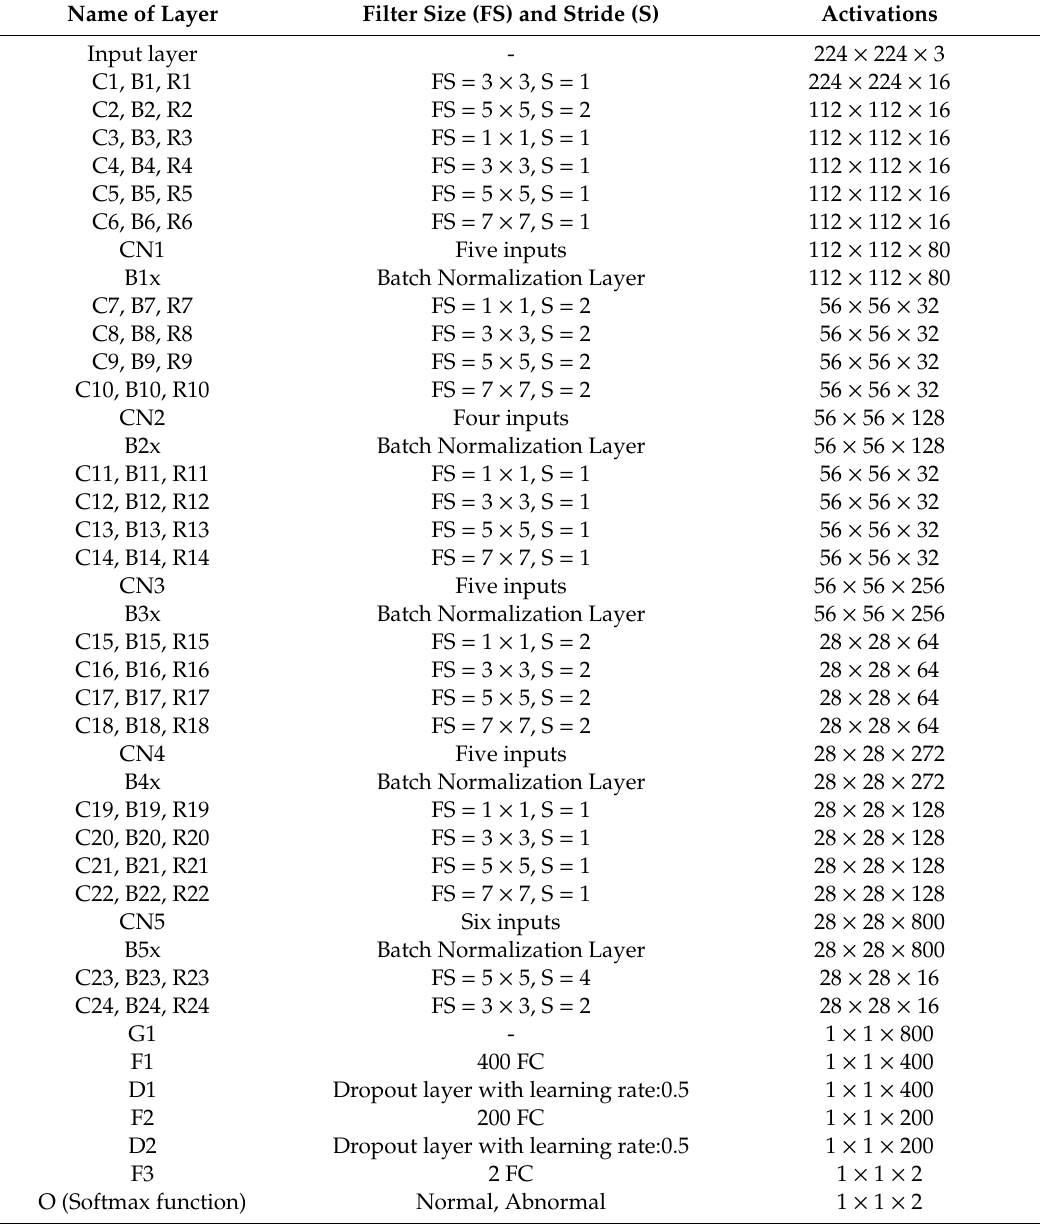
Table 1. Our model architecture, C refers to convolutional layer, B refers to batch normalization Layer, R refers to rectified linear unit layer, CN refers to concatenation layer, G refers to global average pooling layer, D refers to dropout layer, F refers to the fully connected